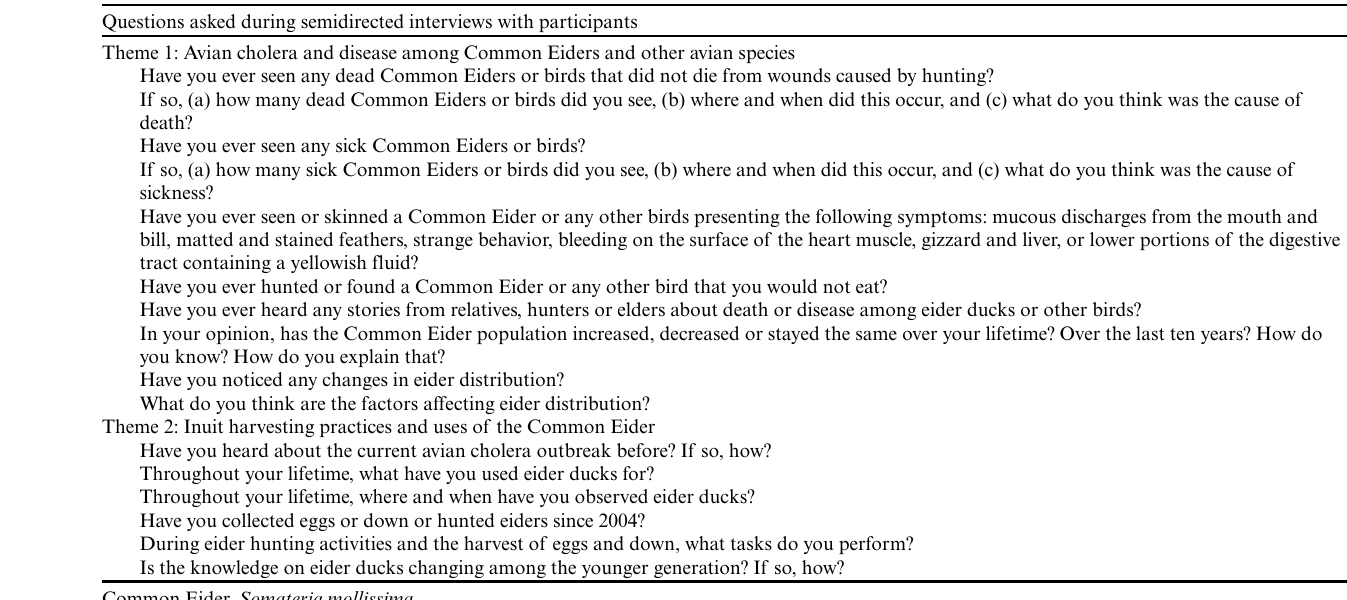
Table 1 . Questions asked and themes discussed during interviews with participants in Kimmirut, Cape Dorset, Coral Harbour, and Igloolik,